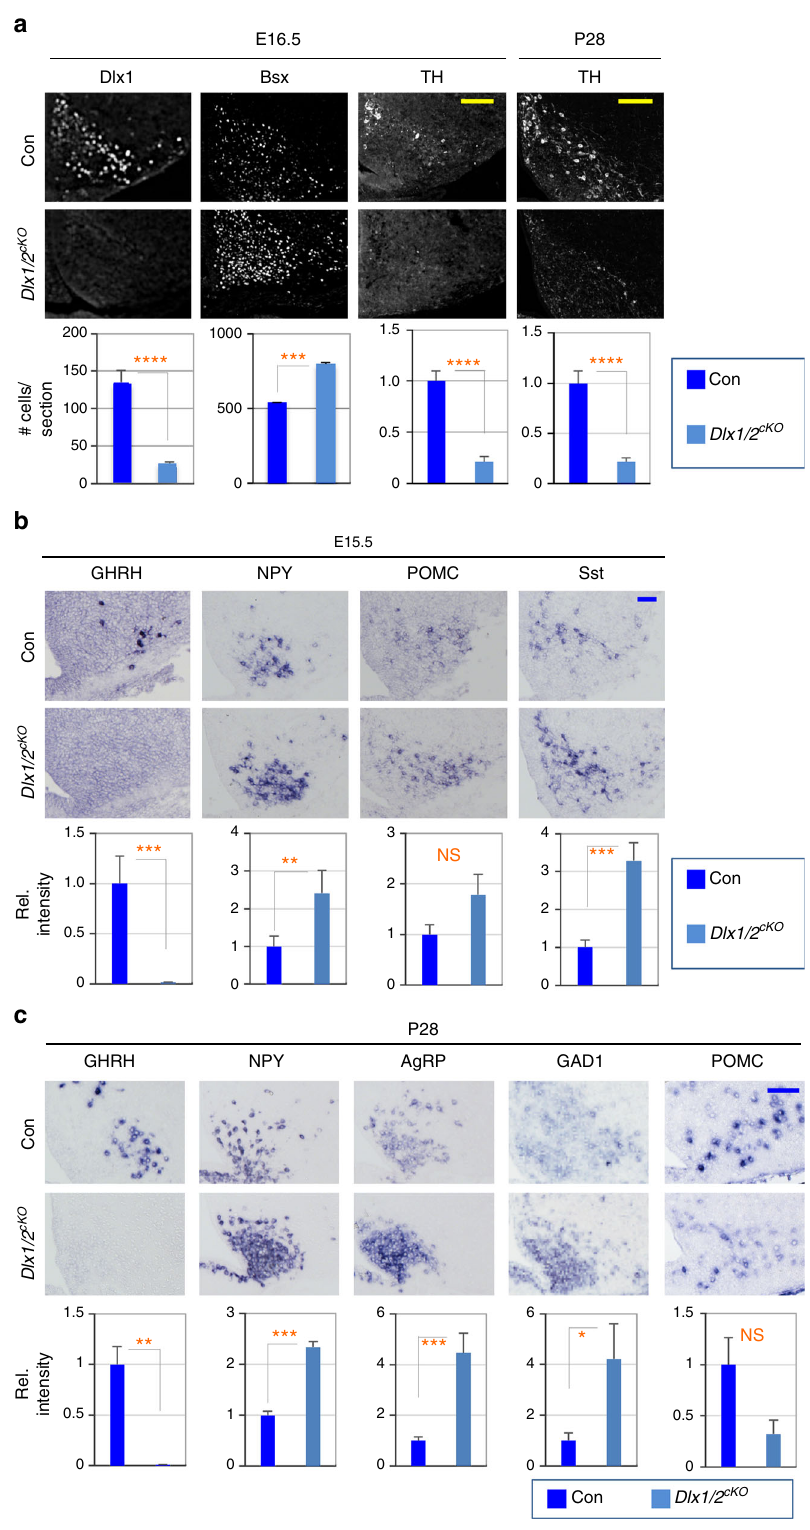
Fig. 2 Expression of arcuate neuropeptides in Dlx1/2 cKO mice. a IHC analyses of E16.5 Dlx1/2 cKO embryos ( n = 4) revealed a signi fi cant decrease in the number of Dlx1 + and TH + cells but a signi fi cant increase in the number of Bsx + cells relative to their littermate controls ( n = 4). Similar observations were made for TH in the ARC of P28 Dlx1/2 cKO mice ( n = 3) relative to their controls ( n = 3). b ISH analyses of Dlx1/2 cKO embryos ( n = 4) revealed abolished expression of GHRH but a signi fi cant increase in the expression of NPY and Sst relative to their littermate controls ( n = 4). c In ISH analyses, P28 Dlx1/2 cKO mice ( n = 3) showed a signi fi cant increase in the expression of NPY, AgRP and GAD1 while losing the expressing of GHRH in comparison to their control mice ( n = 3). The expression of POMC was not signi fi cantly altered ( b , c ). Quanti fi cation was performed with multiple embryos as indicated and at least 3 sections from each embryo, and representative images for only one side of the ARC are as shown. Scale bars, 100 μ m. Statistical differences were determined by Student ’ s t -test: ∗ p < 0.05, ∗∗ p < 0.01, ∗∗∗ p < 0.001, and ∗∗∗∗ p < 0.0001. Bars represent mean, error bars indicate the